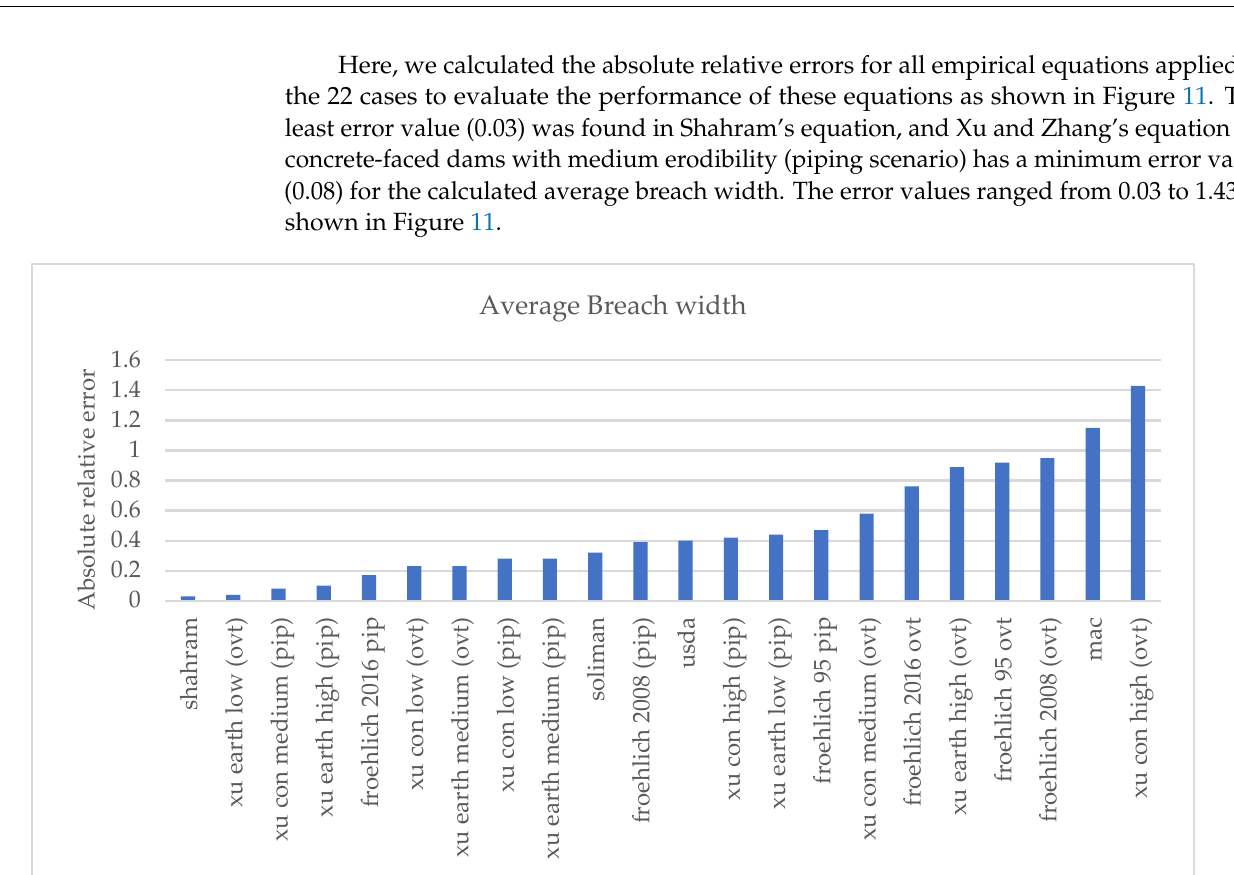
Figure 11. The absolute relative errors for the empirical formulas calculated for the average breach width.